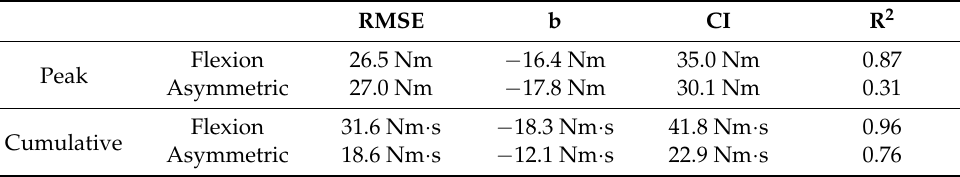
Figure 3. Correlation plot between OMC + PF-based and IMC-based computations of L5/S1 peak moments. Table 2. Bland–Altman bias (b), confidence interval (CI), as well as the coefficient of determination (R 2 ) and RMSE between OMC + PF-based and IMC-based computations for L5/S1 peak and cumulative